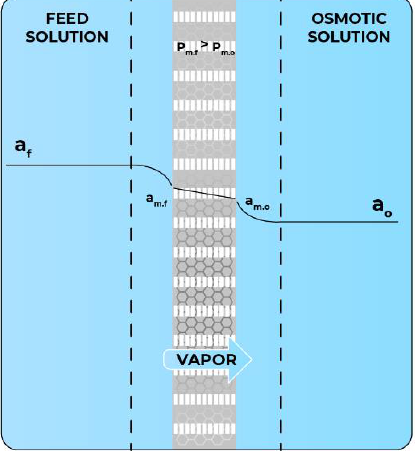
Figure 1. Concentration profiles in osmotic membrane distillation crystallization.